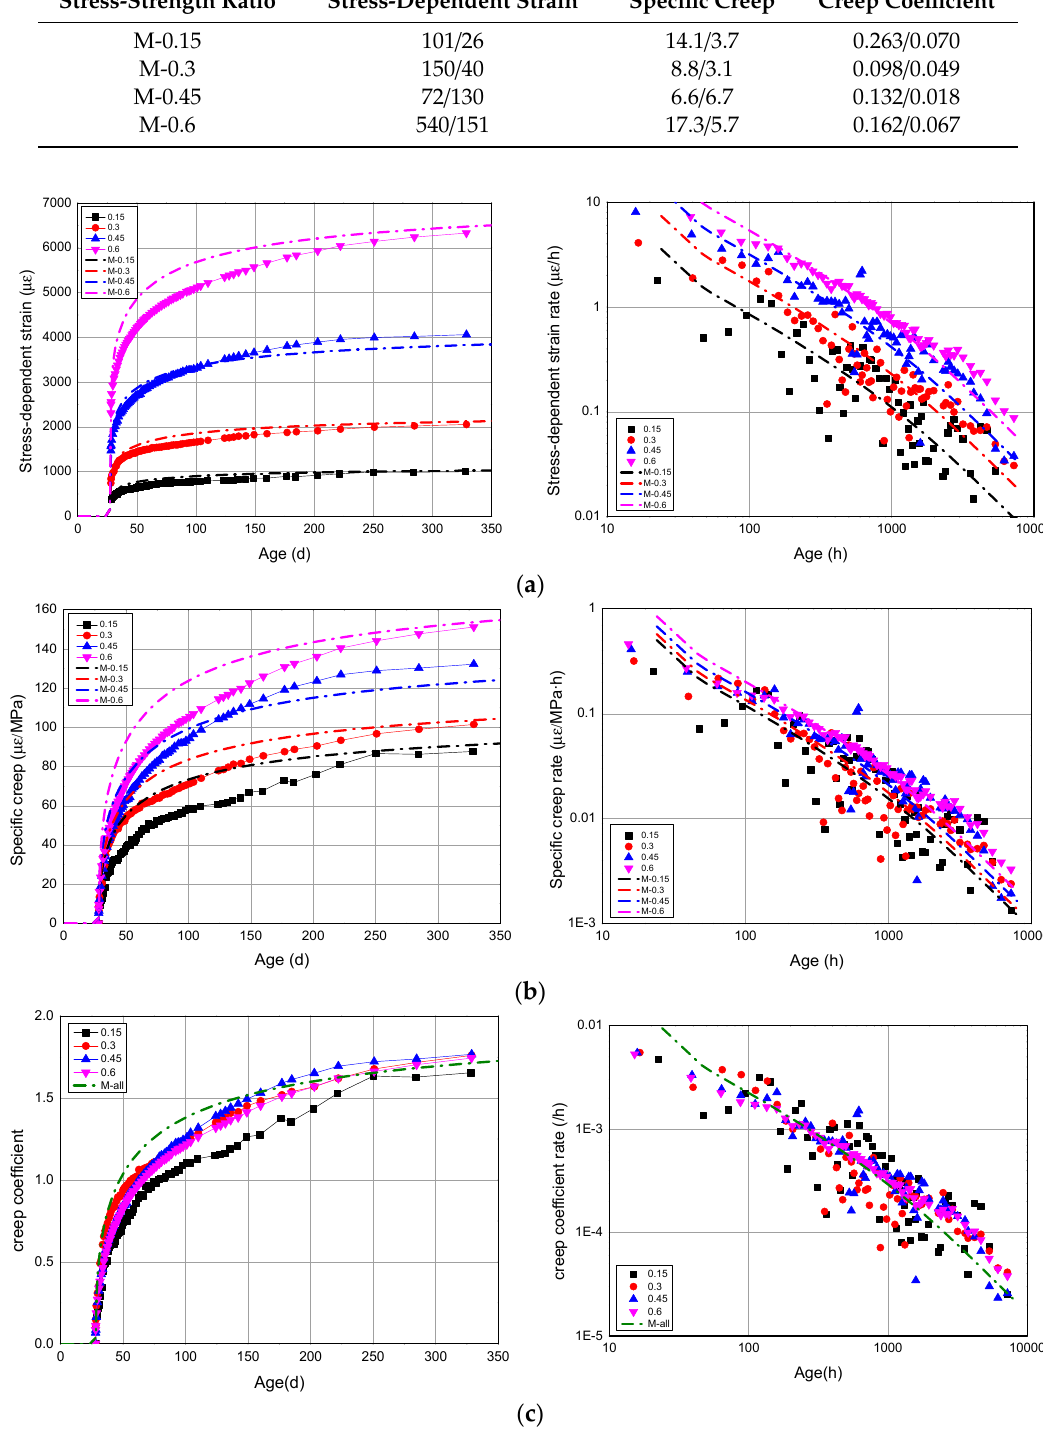
Figure 11. Test values compared with improved creep model. ( a ) stress-dependent strain; ( b ) specific creep; ( c ) creep coefficient. Table 8. The average and standard deviation of residual values by improved model predicted value minus experimental data value (shown as average/standard deviation).